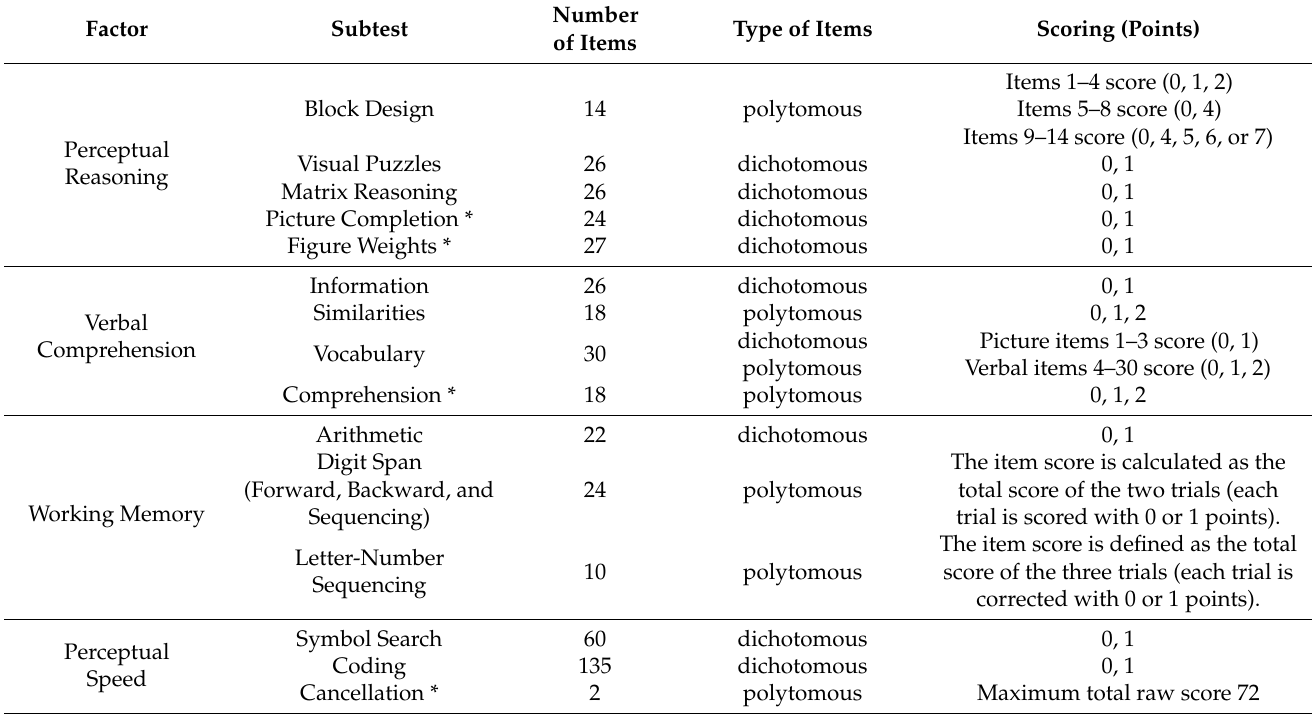
Table 1. Summary of the WAIS-IV